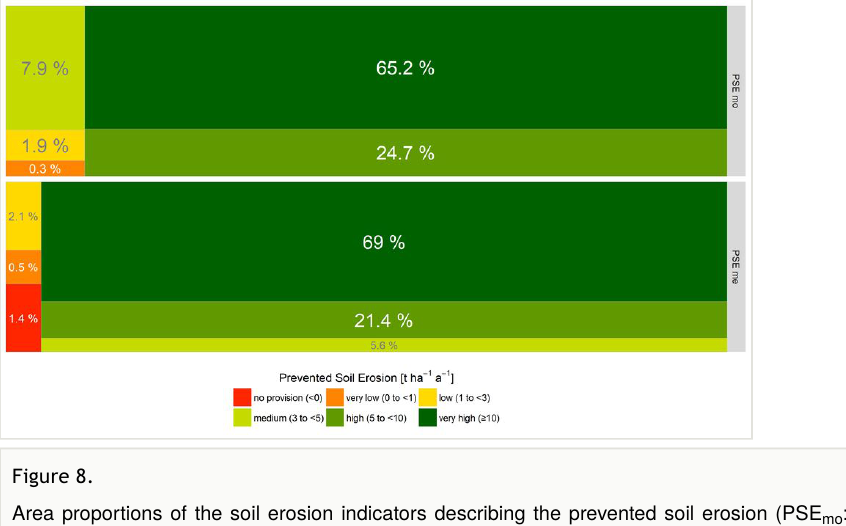
Negative values for PSE